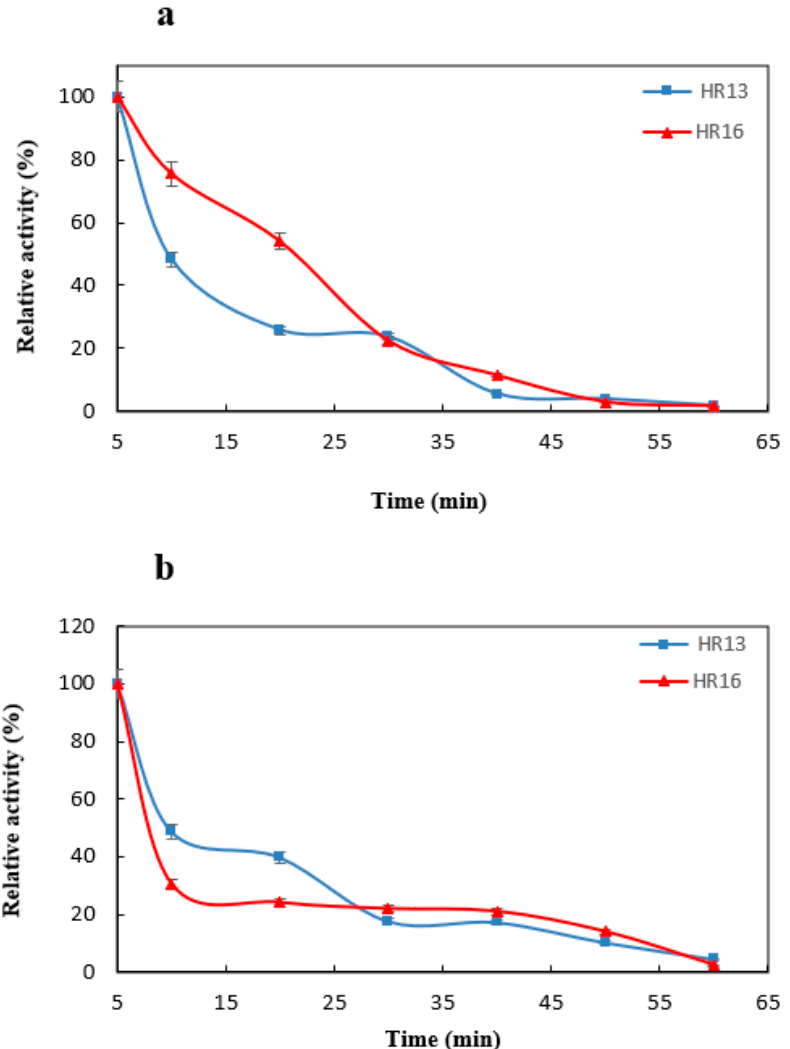
Figure 6. Thermal stability of the α -amylase enzyme activity of HR13 ( (cid:4) ) and HR16 ( (cid:78) ) after incubating the enzymes in a water bath at 80 ◦ C ( a ) and 90 ◦ C ( b ) for different time periods. At 90 ◦ C, irreversible thermal inactivation of the enzyme decreases enzyme activity substantially faster than at 80 ◦ C. After 30 min of temperature incubation, the enzyme activity of B. subtilis strain HR13 reaches less than 20% of its initial activity. About 22% of the enzyme’s initial activity was still present in the B. subtilis strain HR16 enzyme after 30 min of incubation at 90 ◦ C. The irreversible inactivation of enzymes isolated from HR13 and HR16 was investigated and compared at an alkaline pH of 8 (Figure 7). Both forms of the enzyme exhibit a notable decline in activity at pH 8 with extended incubation times. The enzymes of strains HR13 and HR16 preserved 56% and 63% of their initial activity after 30 min of incubation at pH 8, respectively. At pH 12, the activity of the free enzyme decreased as the incubation time increased. After 60 min of incubation at pH 8, the free enzyme in both enzyme forms was reversible to about 18% of its initial